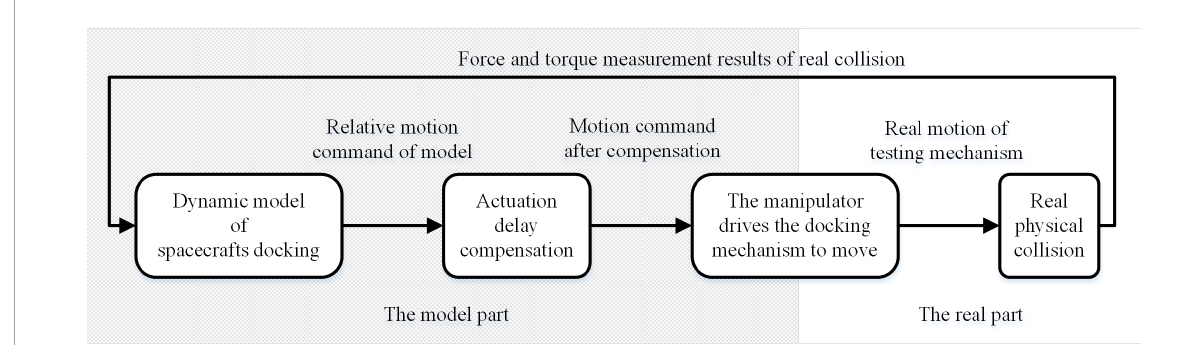
FIGURE1 Semi-physical docking performance test structure.